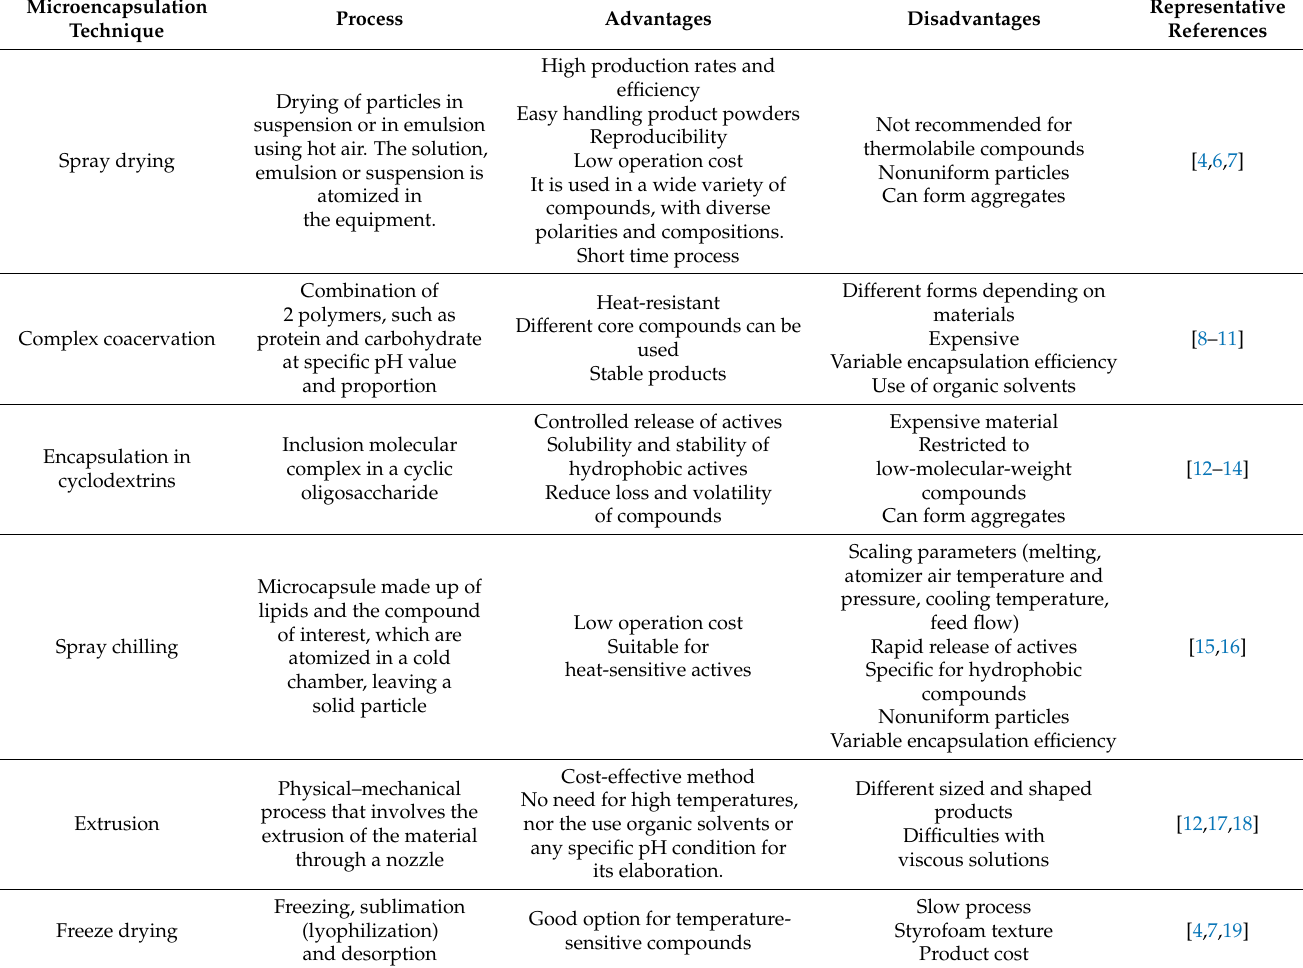
Table 1. Advantages and disadvantages of some common microencapsulation